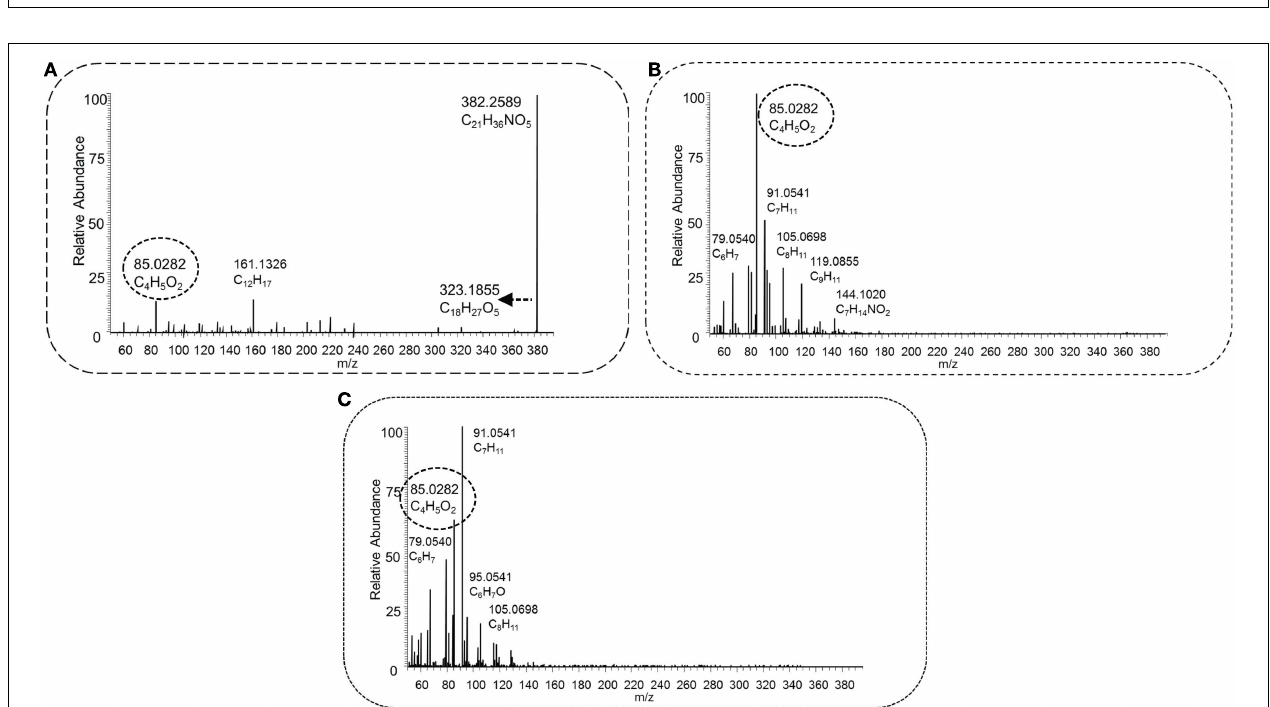
FIGURE 5 | HCD type MS 2 fragmentation spectra obtained at low [30 NCE, (A)], middle [70 NCE, (B)], and high [110 NCE, (C)] energy for precursor mass 316.2118 m / z , with the proposed elemental formula of